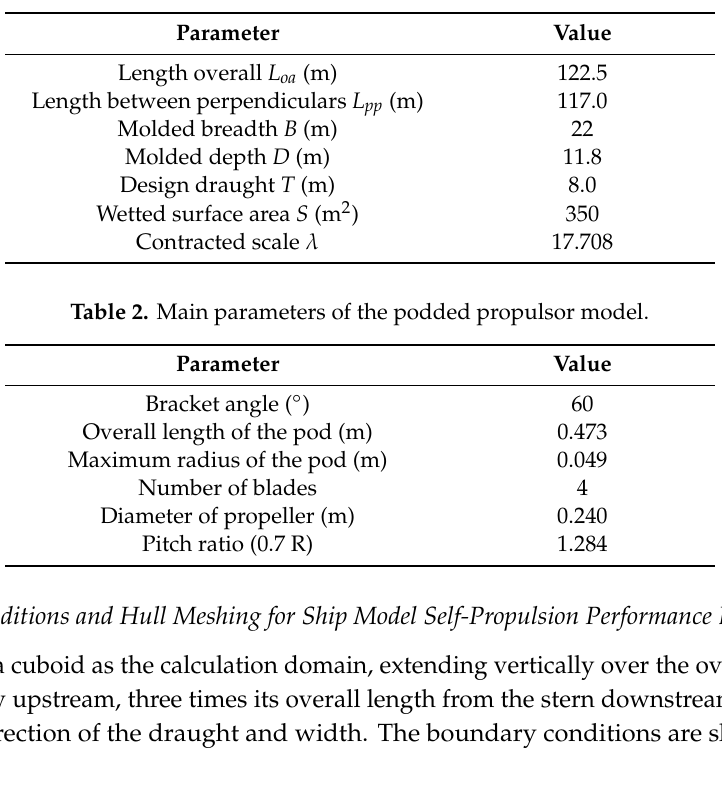
Table 1. Principal dimensional parameters of the ship.